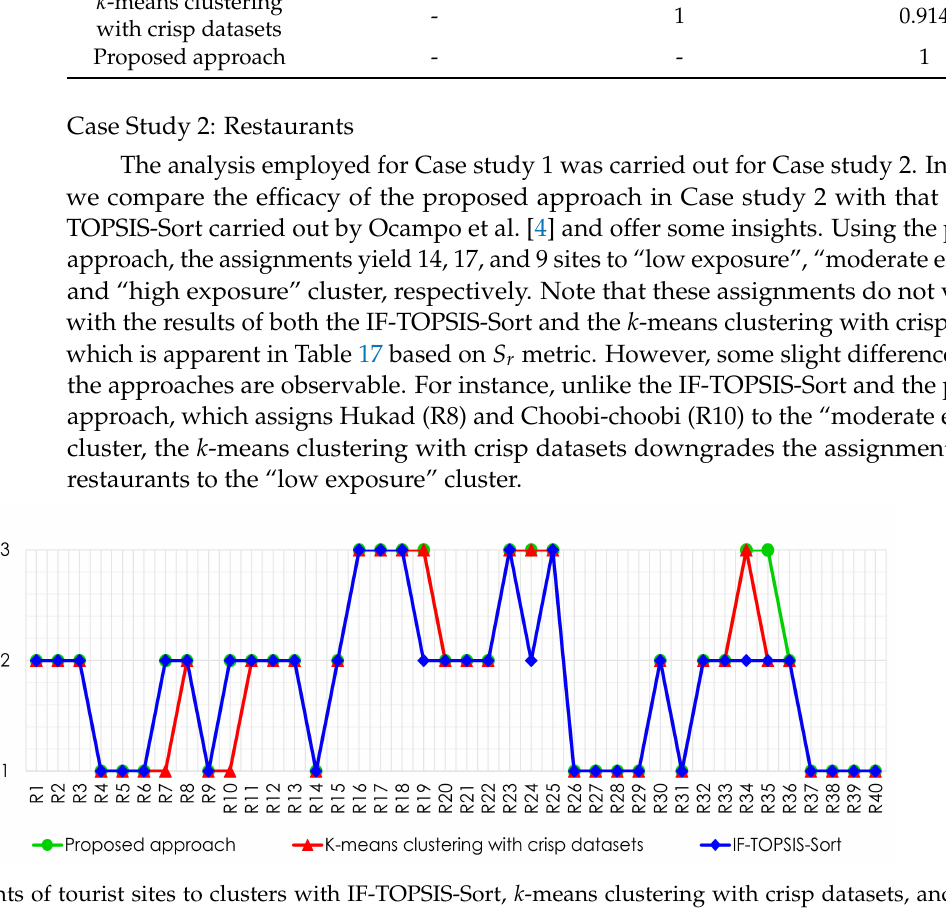
Figure 4. Assignments of tourist sites to clusters with IF-TOPSIS-Sort, k -means clustering with crisp datasets, and the proposed